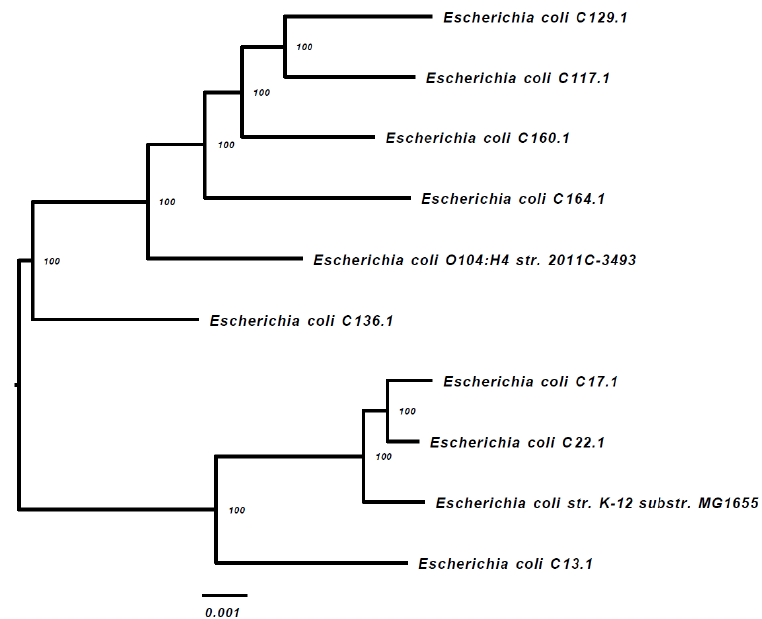
Figure 1. WGS-based phylogenetic tree of the 8 E. coli gut isolates (including two reference strains). The Phylogenetic Tree Building Service of the PATRIC v3.5.36 platform [27]was used to create the tree, as described in the Materials and Methods section. The E. coli